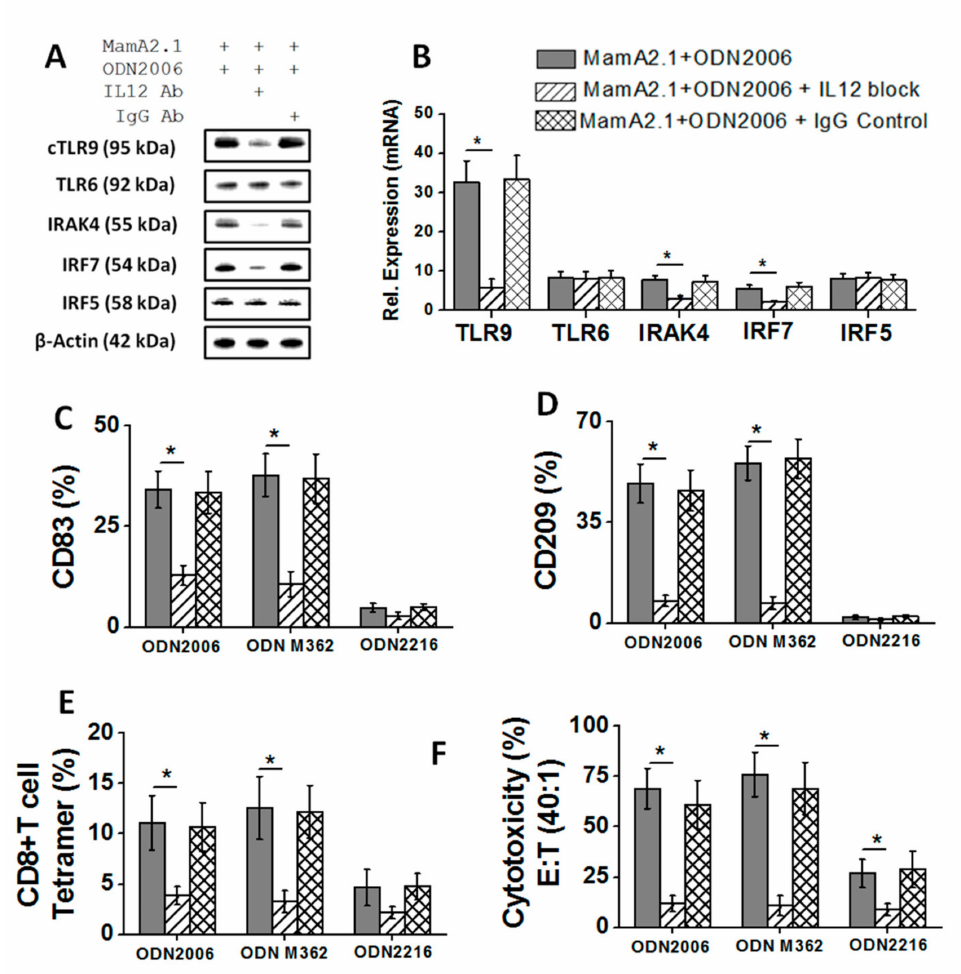
Figure 7. TLR-6 / -9 induced IL-12 secretion mediated the auto-stimulated enhanced expression of TLR-9. ( A , B ) Protein expression and densitometry analysis of TLR-6 / -9 proteins and their downstream signaling factors, namely IRAK4, IRF7, IRF5, and IRF3, following IL-12 blocking by specific monoclonal antibodies with co-treatment of MamA2.1 + ODN2006. IL-12 cytokine release ( C ) and expression maturation marker CD83 ( D ) in THP-1 cells following IL-12 blocking under these treatment conditions. The ability of IL-12 blocked and ODN2006 stimulated THP-1 cells to induce cytotoxic CD8 + T cell responses was studied by tetramer staining ( E ) and cytotoxicity on AU565 breast cancer cells ( F ). All experiments were performed in four independent replicates, and data are expressed as mean ± SD, * p < 0.05 compared with the MamA2.1 peptide treatment